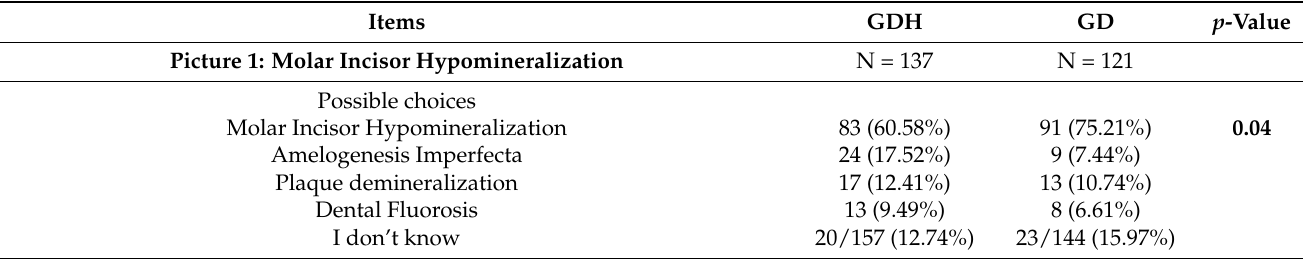
Table 2. Comparison of GDH and GD answers in regard to the clinical images (expressed as number and percentage). Differences between the groups were analyzed by Pearson’s chi-square test or Fisher’s exact